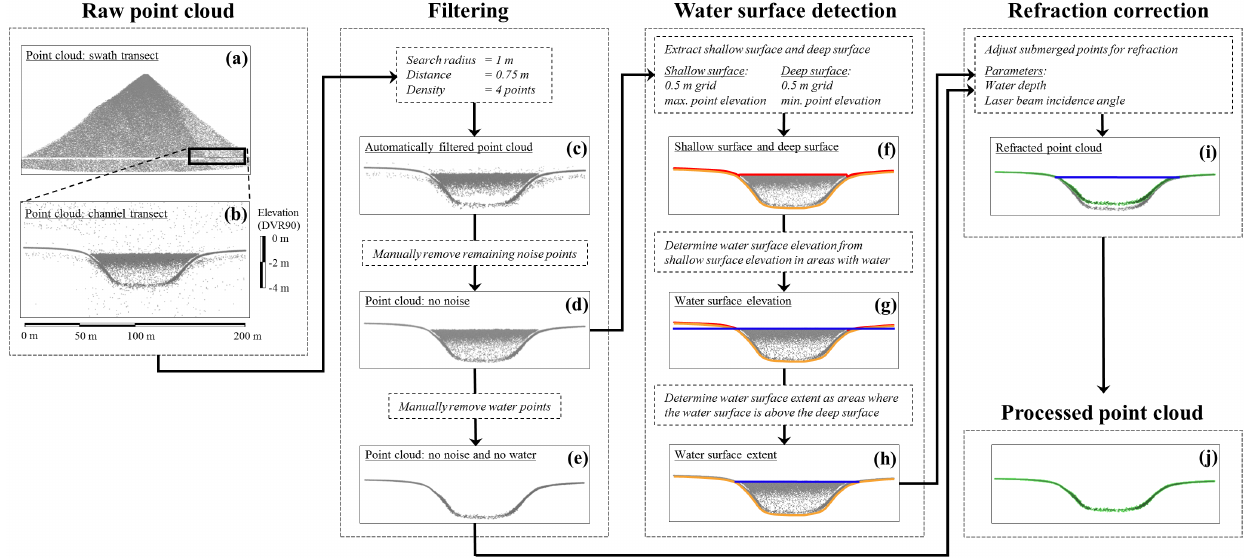
Figure 3. Workflow for processing the lidar point cloud. Panel (a) shows point cloud from a single swath with points ranging from − 100 to 300m elevation; (b) zoom-in on a cross section of the flood channel with elevation exaggerated × 15 for visualization purpose; (c) – (e) method for filtering the point cloud; (f) – (h) method for detecting a water surface (blue) based on the extraction of a shallow surface (red) and a deep surface (orange); (i) correction for the effect of refraction on all the submerged points; (j) processed point